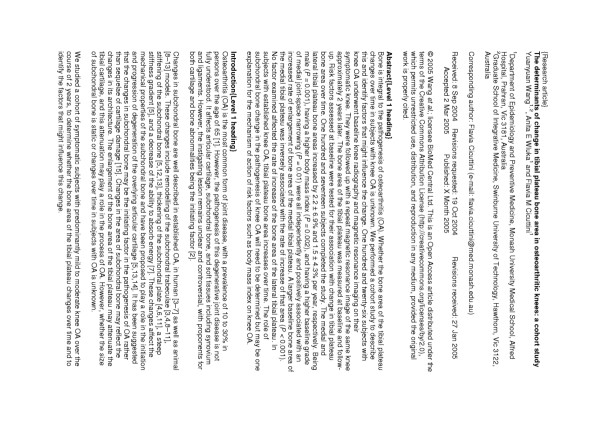
Axial T1-weighted fat-saturated 3DMRI image showing measurement of tibial plateau bone area. The area of medial (Roi 2) and lateral (Roi 1) tibial plateau bone is measured manually on the first image that shows both tibial cartilage and subchondral bone (left), and on the next distal image (right). An average of the two areas is used as an estimate of the tibial plateau bone area. MRI, magnetic resonance image; Roi, region of interest.